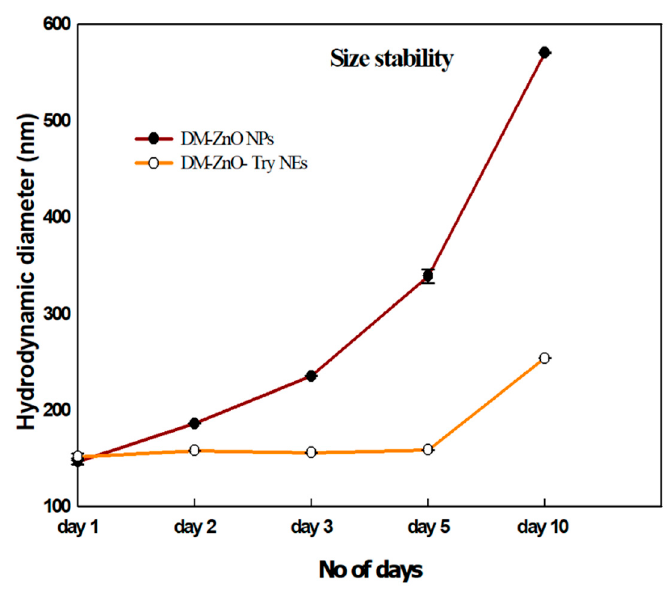
Figure 5. Size stability of DM-ZnO NPs and DM-ZnO-Try NE with the time